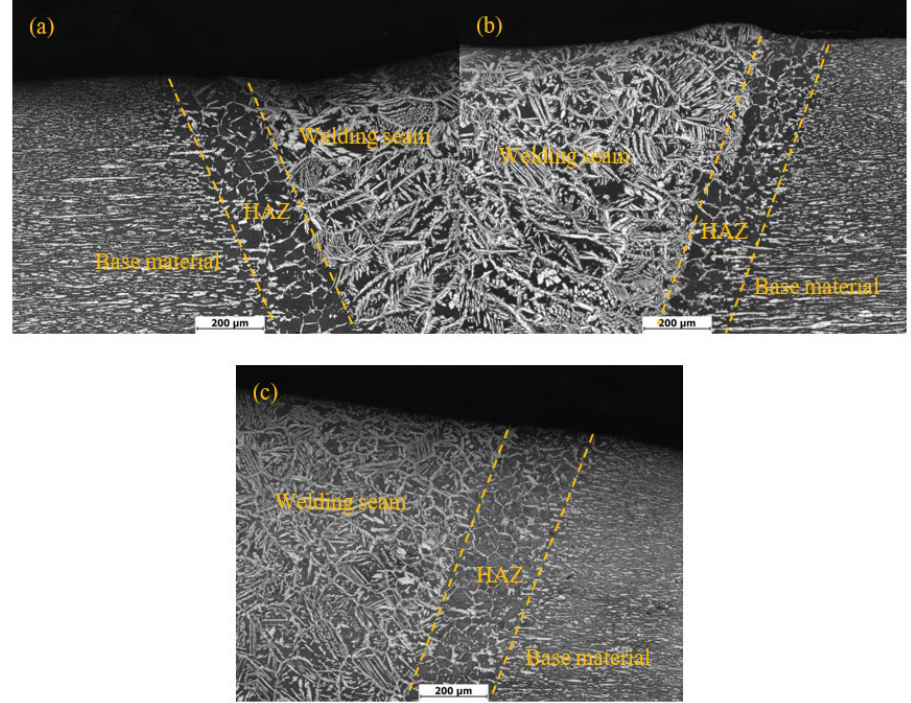
Figure 4. Metallographic structure of DSS 2205 heat affected area with different treatment methods: ( a ) Untreated; ( b ) pneumatic chipping hammer; ( c ) ultrasonic impact peening.